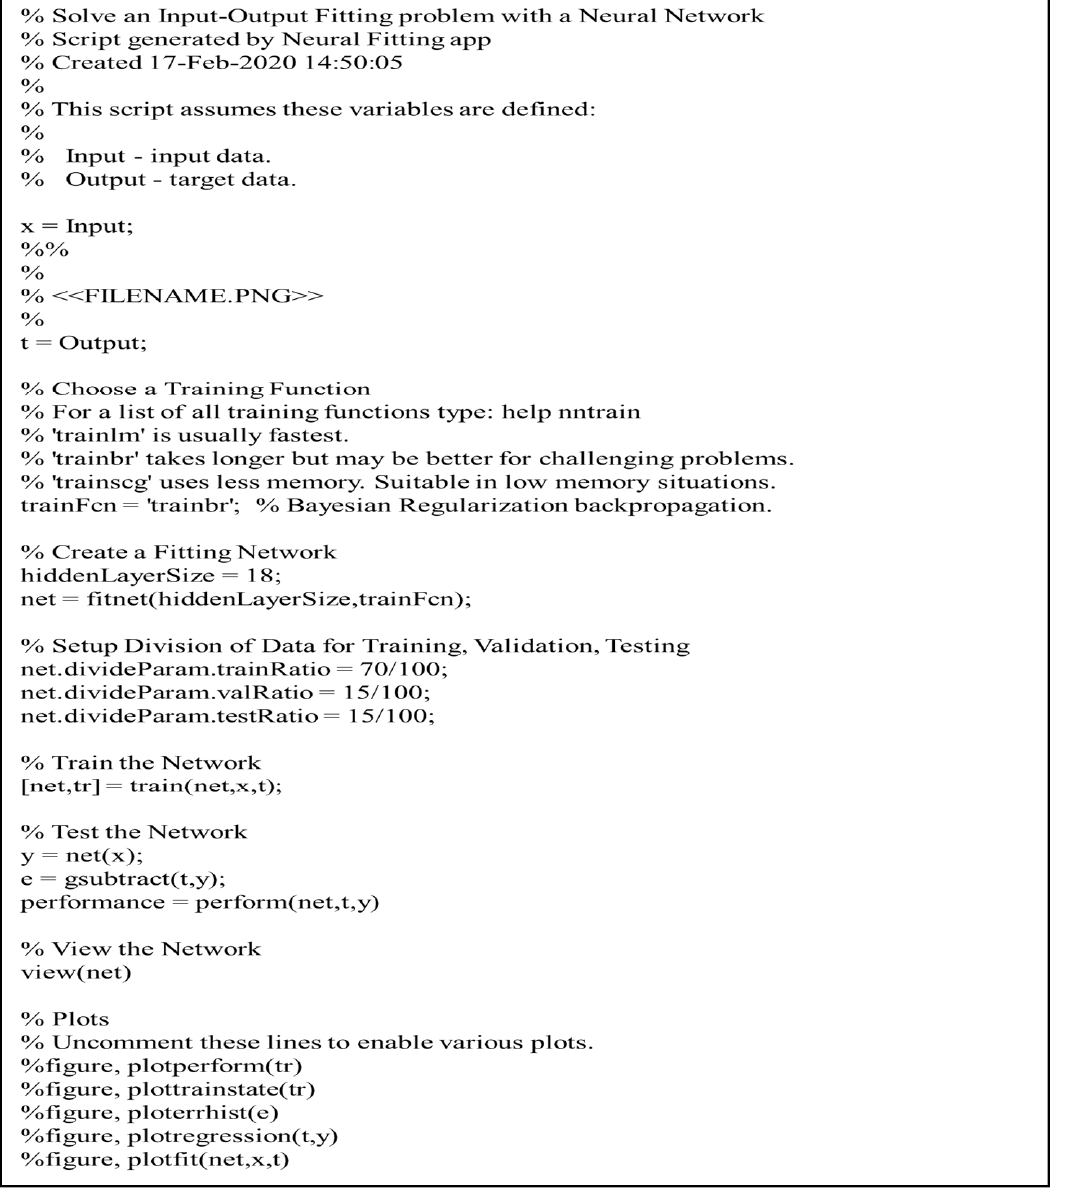
Figure 5. MATLAB script of eighteen neurons.